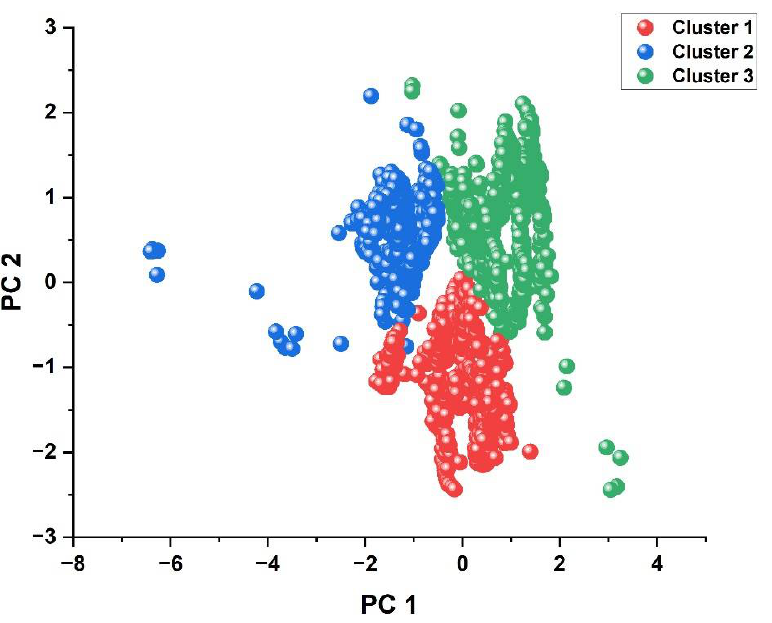
Figure 9. Scatter plot of BIOFISH PC scores after varimax rotation. PC 2 scores are plotted against PC 1 scores. Observations are colored according to the CA results. The observations of the three clusters are clearly differentiated by their respective PC scores.